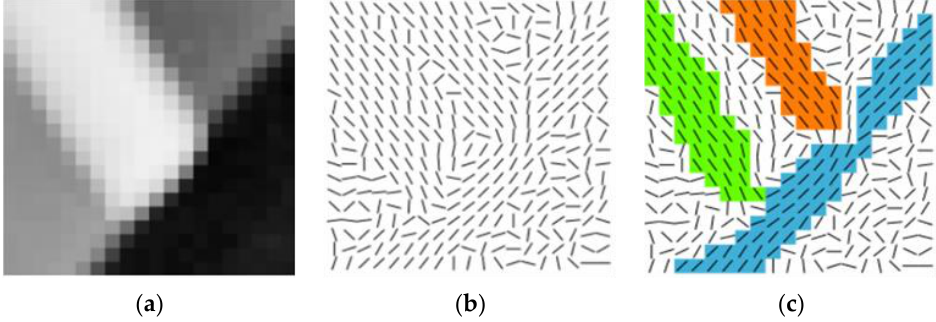
Figure 2. Gradient fields and line-support region of LSD Algorithm: ( a ) Original image; ( b ) Gradient fields; ( c ) Line-support region.